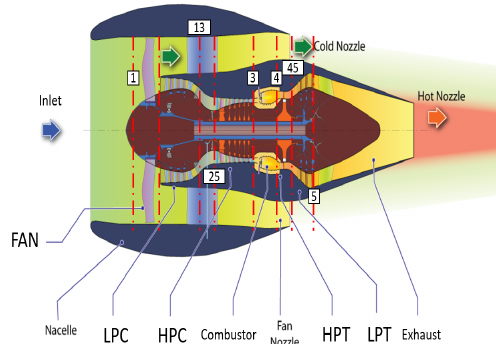
Figure 1. Schematic layout of the CFM56 engine (modified from [10]). Vertical dot-dashed lines indi- cate separation between different engine components and numbers label the various engine